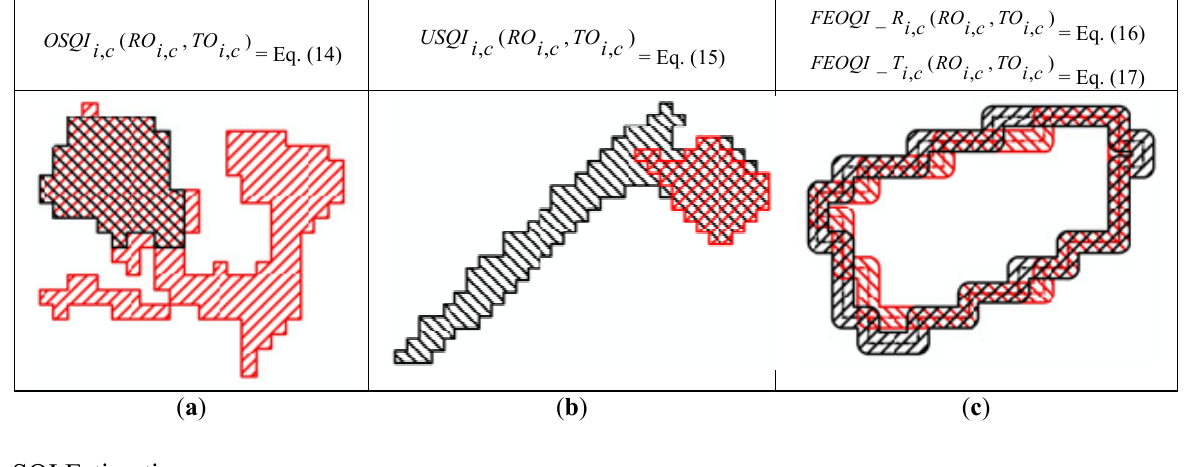
Figure 5. Illustration of the four local Spatial Quality Indicator (SQI) estimators adopted in the probability sampling protocol for thematic map accuracy assessment selected from [32]. The i -th reference image-object belonging to land cover (LC) class c , identified , is shown in red and the mapped (test) image-object, located via Equation (12) and as RO i , is shown in black. ( a ) Example where the OSQI (RO ,TO ) value is identified as TO i,c i,c i,c i,c (RO ,TO ) is low. ( c ) example where 1 ≥ low. ( b ) example where the USQI i,c i,c i,c (RO ,TO ) > FEOQI_T (RO ,TO ) ≥ FEOQI_R i,c i,c i,c i,c i,c i,c